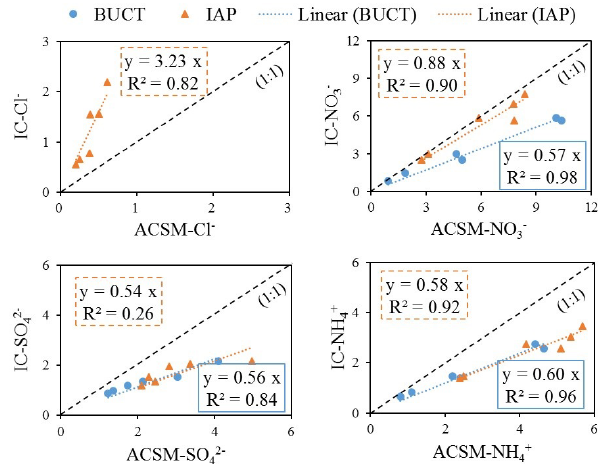
Figure 2. Scatter plots of the median mass concentrations of Cl − , NO − , SO 2 − and NH + measured by the 10 labs (IC-Cl − , IC-NO − 3 4 4 ) versus the nonrefractory (NR) chemical IC-SO 2 − and IC-NH + 4 4 species from ACSM (ACSM-Cl − , ACSM-NO − ) from BUCT and ACSM-NH + 4